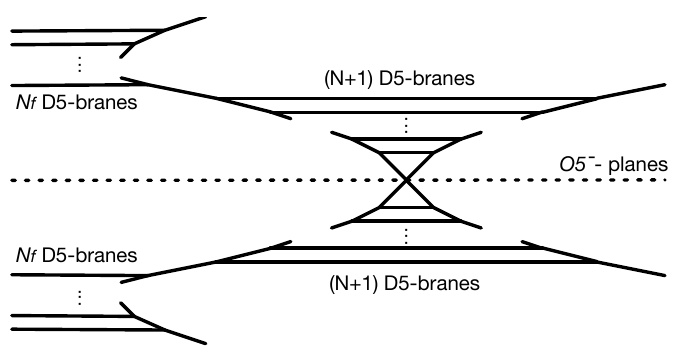
Figure 1 . The 5-brane web diagram with O 5 -plane including the mirror image. This corresponds to the 5d N = 1 Sp( N ) gauge theory with N flavors. f